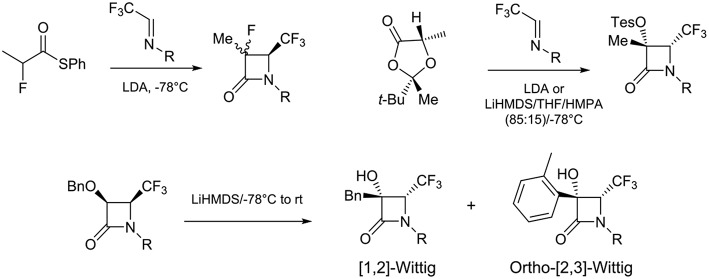
Approaches of C-3 disubstituted 4-CF3 β-lactams.